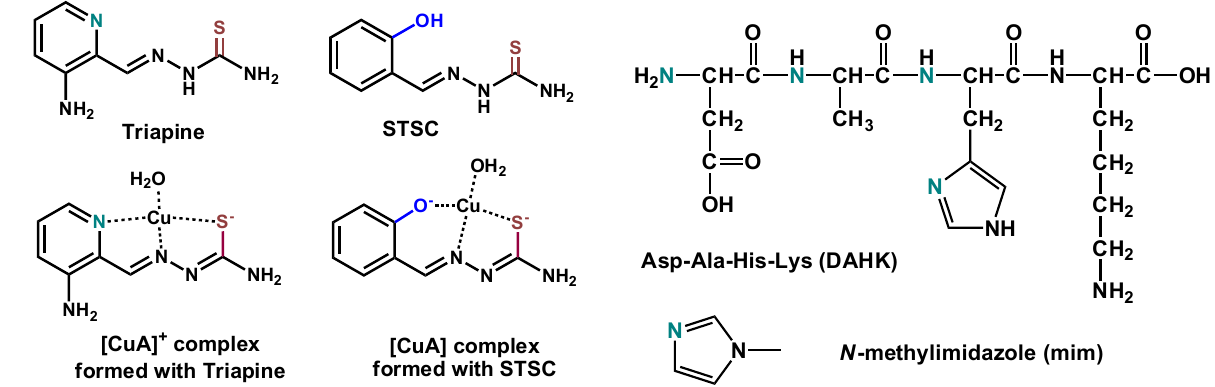
Scheme 1. Chemical structures of Triapine, STSC in their neutral forms, and their copper(II) complexes predominating at pH 7.4, and structures of the binding models (DAHK, mim).